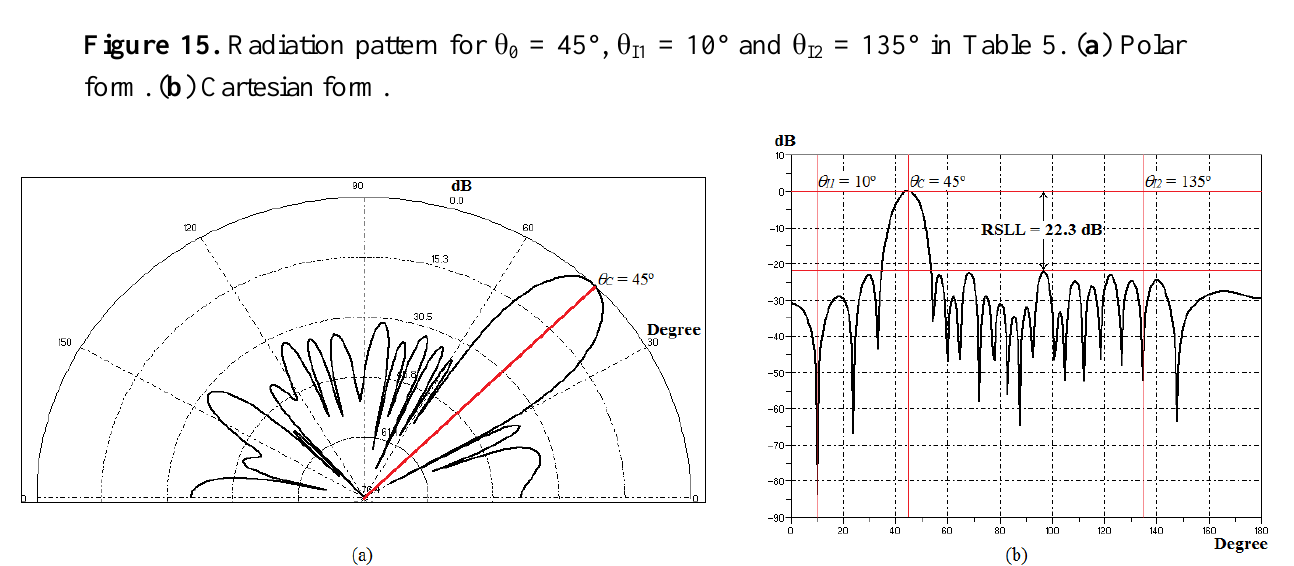
= 45°, θ = 10° and θ = 135° in Table 5. ( a ) Polar 0 I1 I2